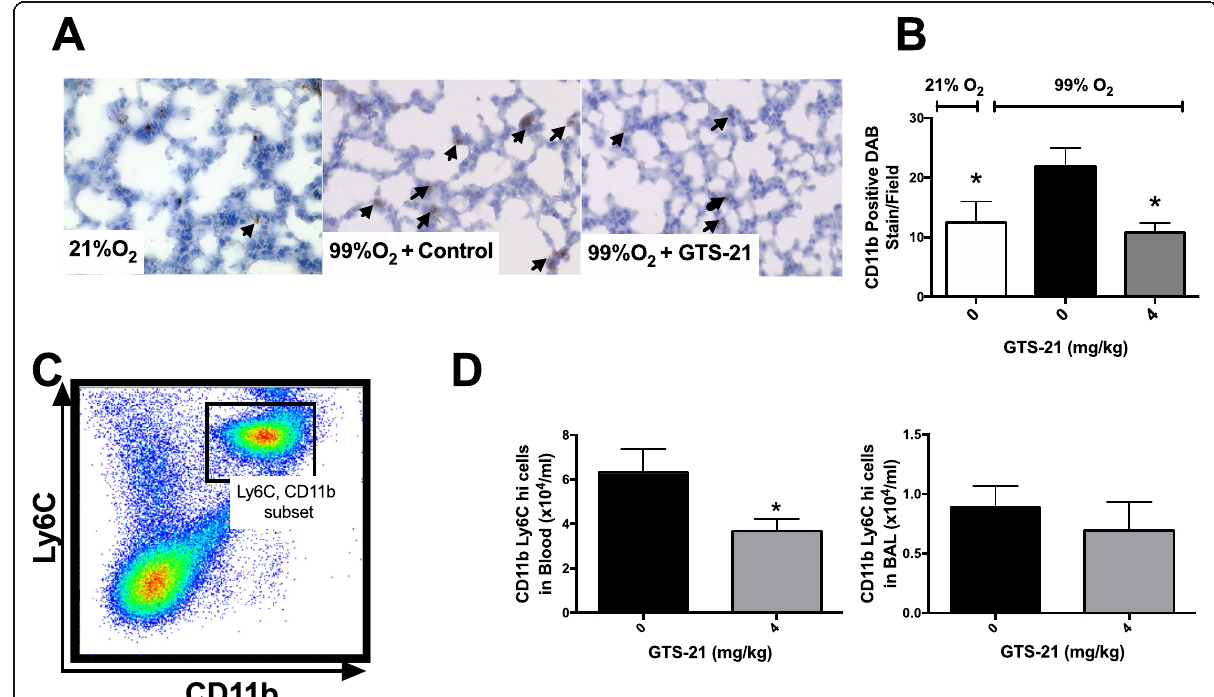
Fig. 4 The sytemic administration of GTS-21 inhibits the infiltration of CD11b + monocytes/macrophages in the lungs of mice exposed to hyperoxia. C57BL/6 mice were exposed to ≥ 99% O 2 and treated with vehicle (0mg/kg) or GTS-21 (4mg/kg) as described in Fig. 1. The lungs were perfused with sucrose, frozen in OCT and cryosectioned. Immunohistochemistry was performed to detect CD11b. a Representative images of lung sections showing DAB positive cells from either control or GTS-21-treated mice. b The total number of CD11b positive DAB stain per field. BAL was harvested at the end of hyperoxia exposure. c-d Cells from the BAL and blood samples were labeled with CD11b and Ly6c antibodies and analyzed by flow cytometry. c Gating for CD11b + and Ly6c cells in the BAL is shown. d The quantification of the total number of CD11b + and Ly6c + in BAL and blood samples analyzed by flow cytometry. Data represent the mean±SEM from two independent experiments ( n =4